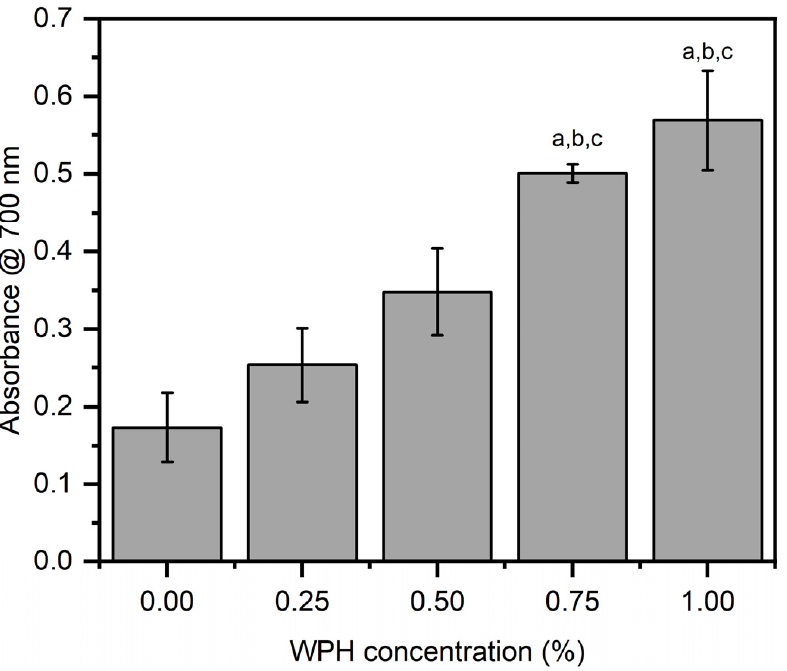
Figure 5. FRAP analysis of chitosan/WPH films containing different concentrations of WPH. Data are presented as an average of three measurements ± standard deviation. Values with different letters on the top of bars are significantly different ( p < 0.05) and determined by using a Bonferroni post hoc test in a one-way ANOVA analysis—a, b, c are relative to films comprising 0 wt%, 0.25 wt% and 0.5 wt% WPH, respectively.